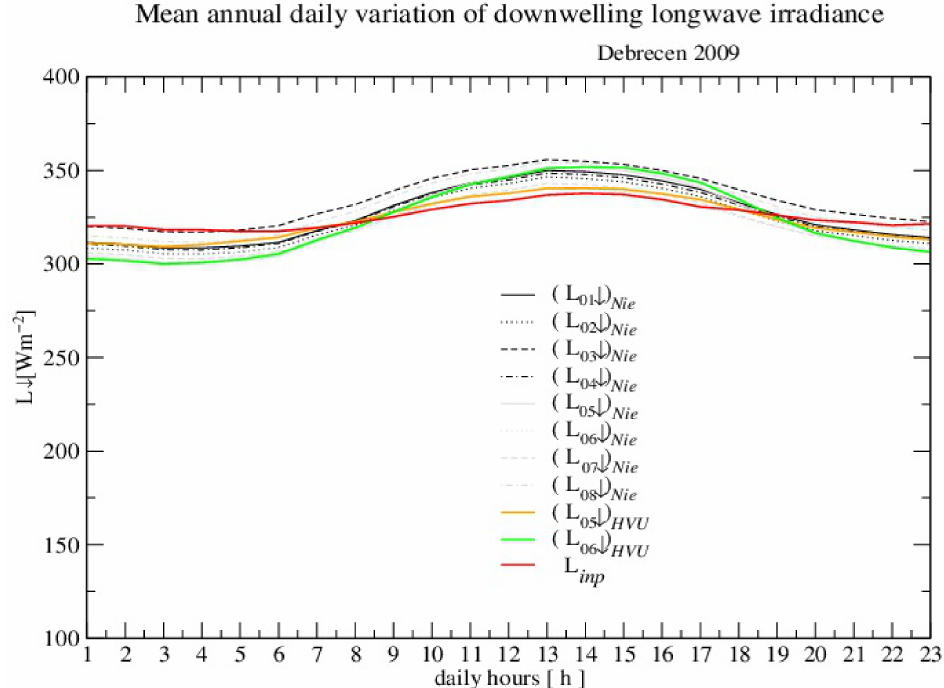
Figure 7. Mean annual daily variation of all modeled sky downwelling LW irradiance Niemelä et al. [43] combined with all the clear sky parameterizations ( L 0 i , i = 1,...,8 ↓ ) (W m − 2 ) de- scribed in Section 6.1.1 are represented with black and grey lines and marked from ( L 01 ↓ ) in Nie Table 8. Two parameterizations: ( ( L 05 ↓ ) and ( L 06 ↓ ) ) based on Holtslag and Van Ulden [5] HVU HVU are represented in colored lines. See, also, Tables 11, 12 and